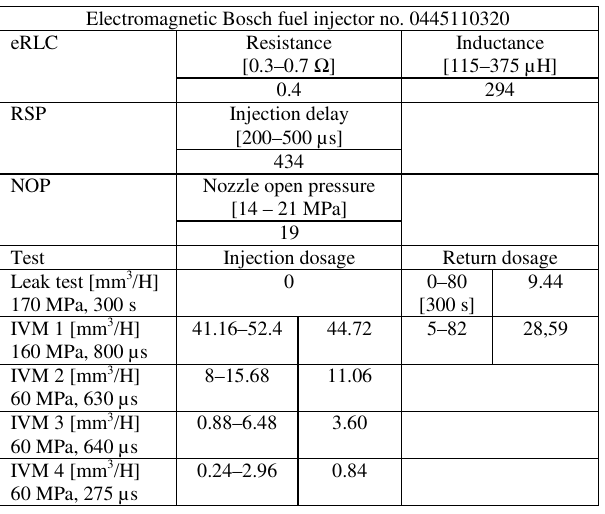
Table 3. Test results of good working piezoelectric Bosch fuel injector research